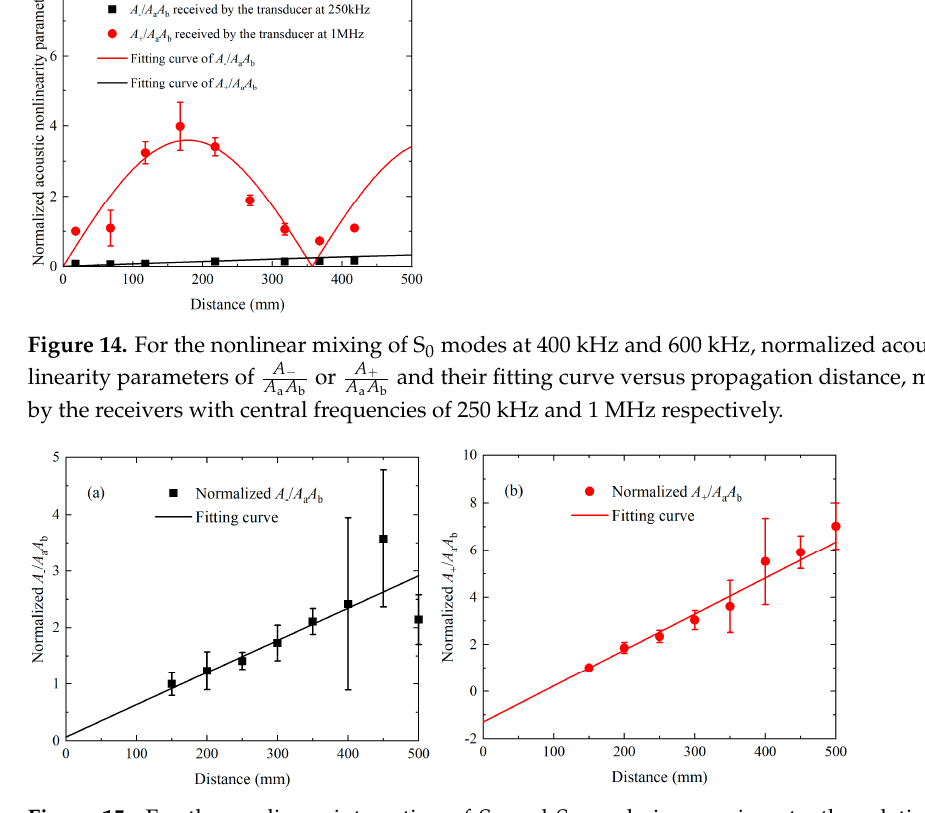
( a ) or A + ( b ) and propagation distance, as well A a A b A a A b A A + ( b ) and propagation distance, as ( a ) or A A A A a b a b